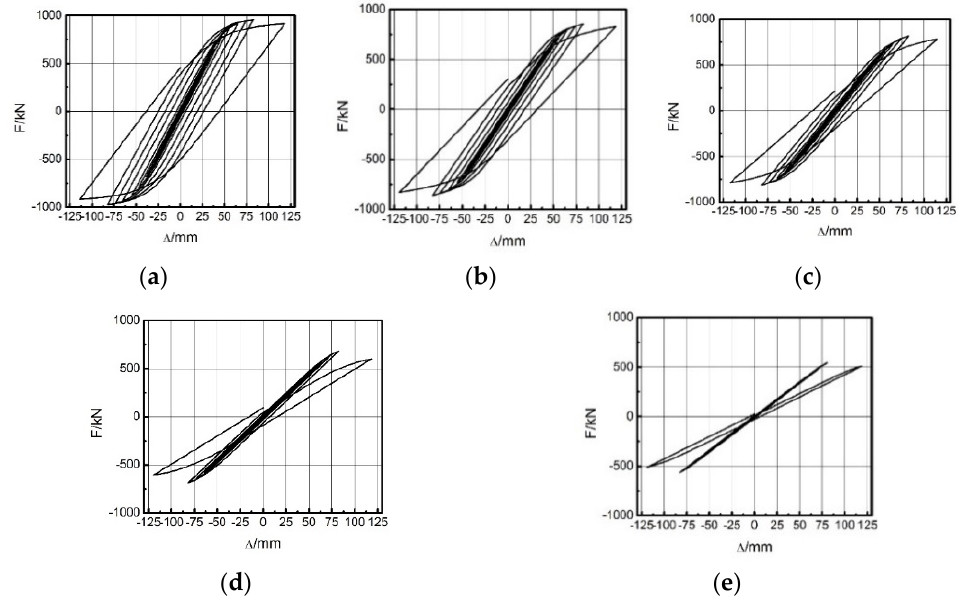
Figure 15. Hysteresis curves of the first group of frames. ( a ) F1; ( b ) F2; ( c ) F3; ( d ) F4; and ( e ) F5. Table 5. Cumulative energy dissipated by the EDCWs.